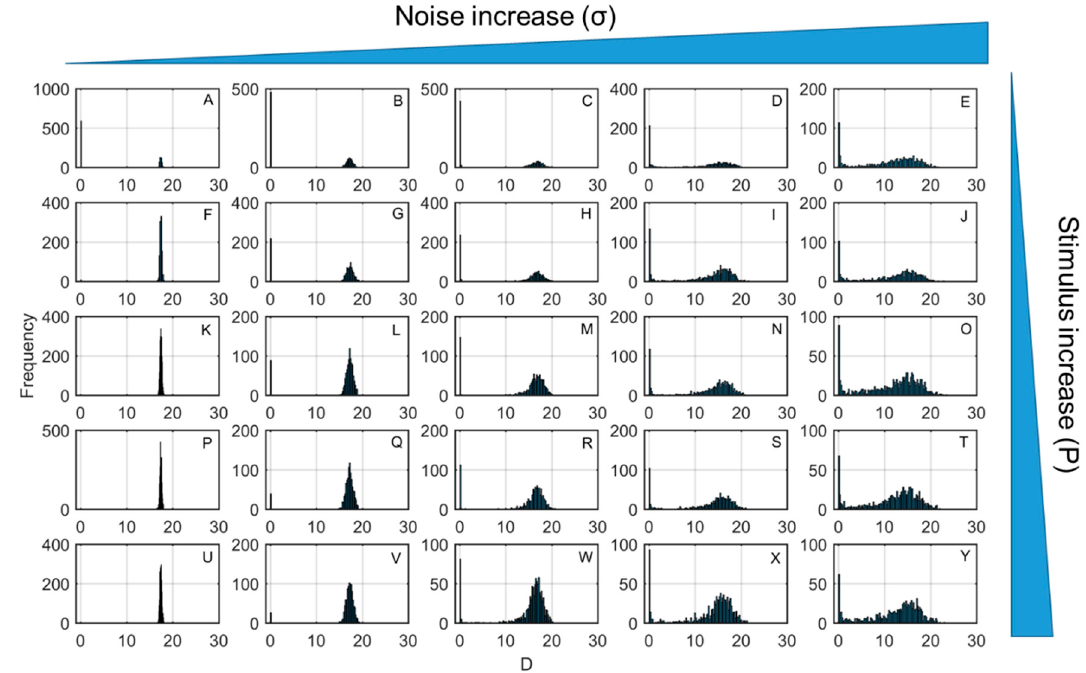
Figure 4. Distribution of tissue damage ( D ) end values at 500 h for increasing levels of noise ( σ ) and pathogen stimulus ( P ). From left to right (e.g. from A to E, F to J, K to O, P to T, U to Y) noise level increases and from top to bottom (e.g. from A to U, B to V, C to W, D to X, E to Y), stimulus level (initial condition of P ) increases.